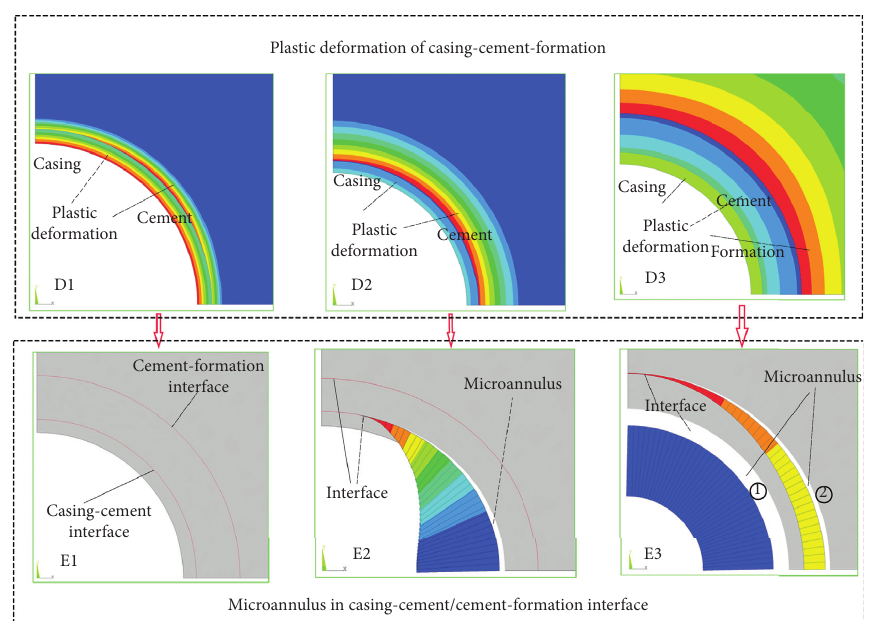
Figure 9: Microannulus caused by elastic-plastic deformation of the casing, the cement, and the formation.